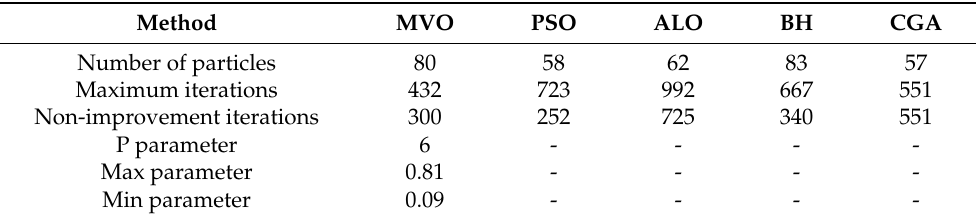
Table 2. Parameters of the continuous methods employed here in the master